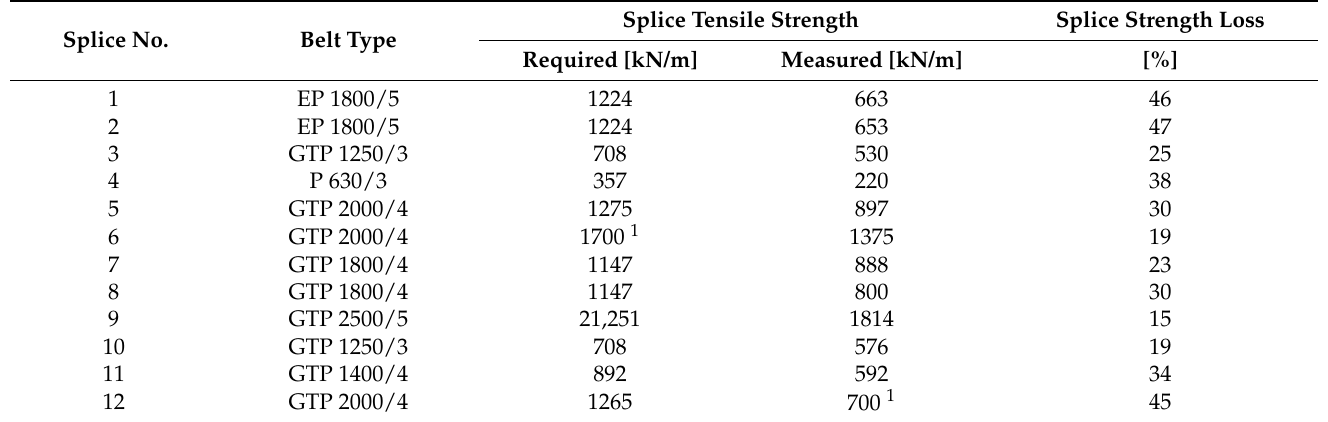
Table 2. Results of tensile strength tests for industrial splices.